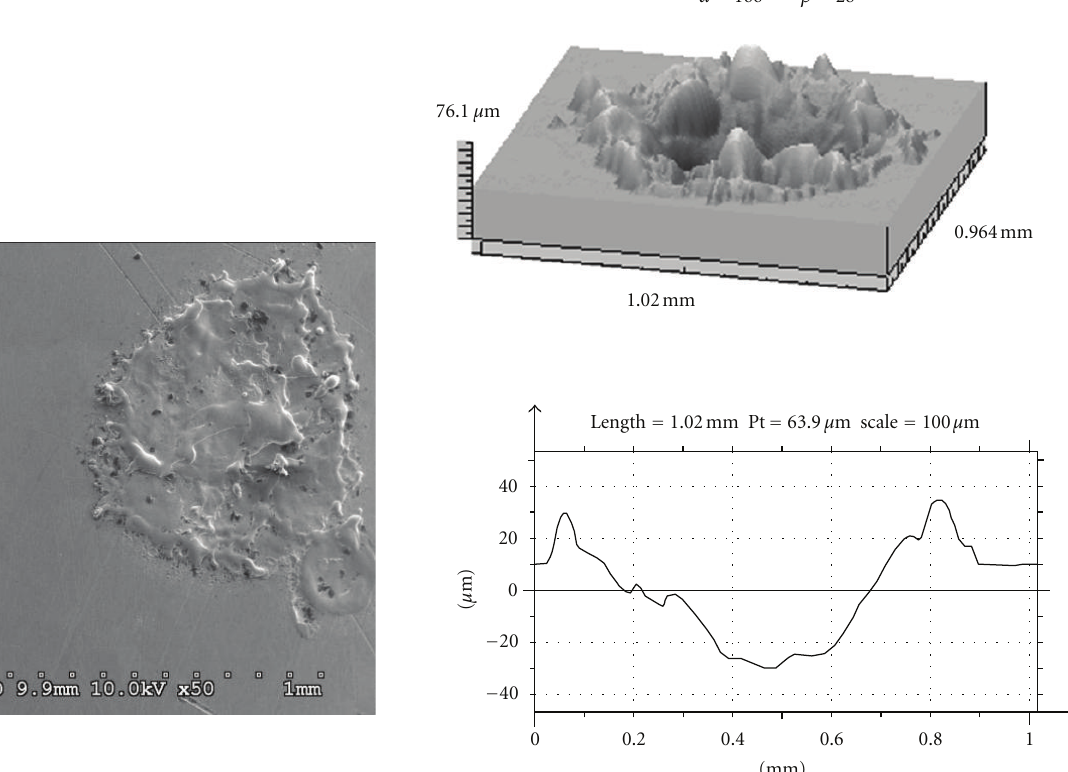
Figure 1: The SEM image of an individual electric discharge on the machined surface, its 3D view, and its profilogram ( U = 80 V, I = 48 A, Ti = 400 μ s).